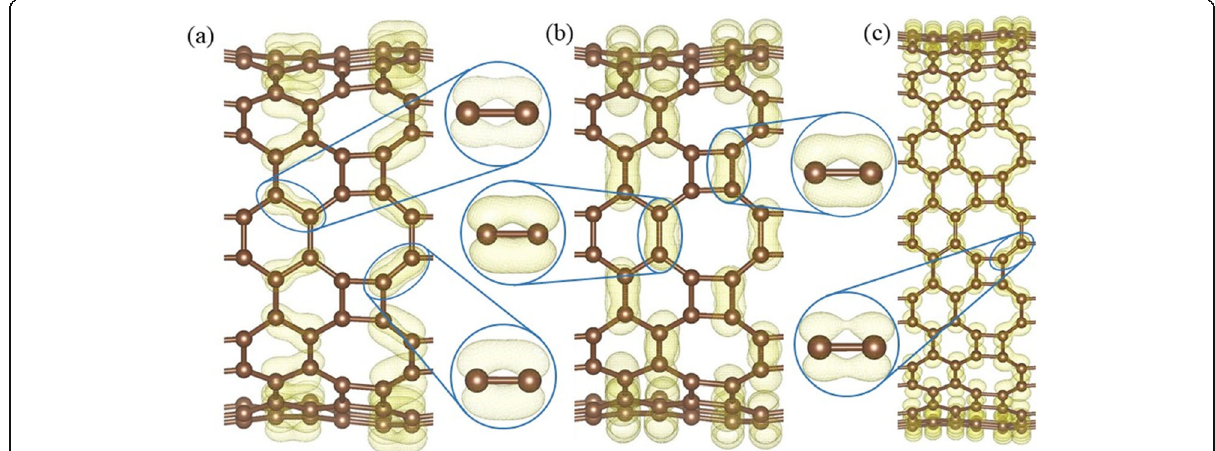
Fig. 11 Band decomposed charge densities at ( a ) VBM, and ( b ) CBM of HOT graphene nanotube (1,0)9; ( c ) charge densities around the Fermi level of the HOT graphene nanotube (1,0)15 with the localized π bond in the enlarged side view